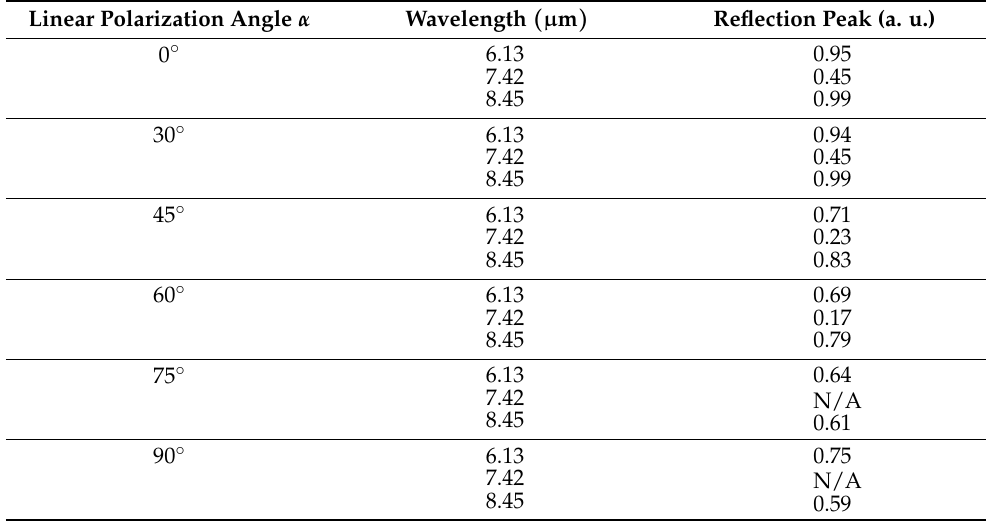
Figure 2. Absolute reflection (top row) and relative reflection (bottom row) spectra of structures 1C, 2C and 3C, for different linear polarization states of the input electric field. As the fractal layers are introduced, the smoothness of the response is increased. Additionally, for specific frequencies, the relative reflection coefficient is zero for all polarization states, which leads to zero-dichroism behavior as a function of polarization. Table 2. Peak values associated with the reflection spectrum of structure 1C, at linear polarization angles α = 0 ◦ , α = 30 ◦ , α = 45 ◦ , α = 60 ◦ , α = 75 ◦ and α = 90 ◦ , where N/A stands for no reflection peak. These frequencies correspond to frequencies of minimal